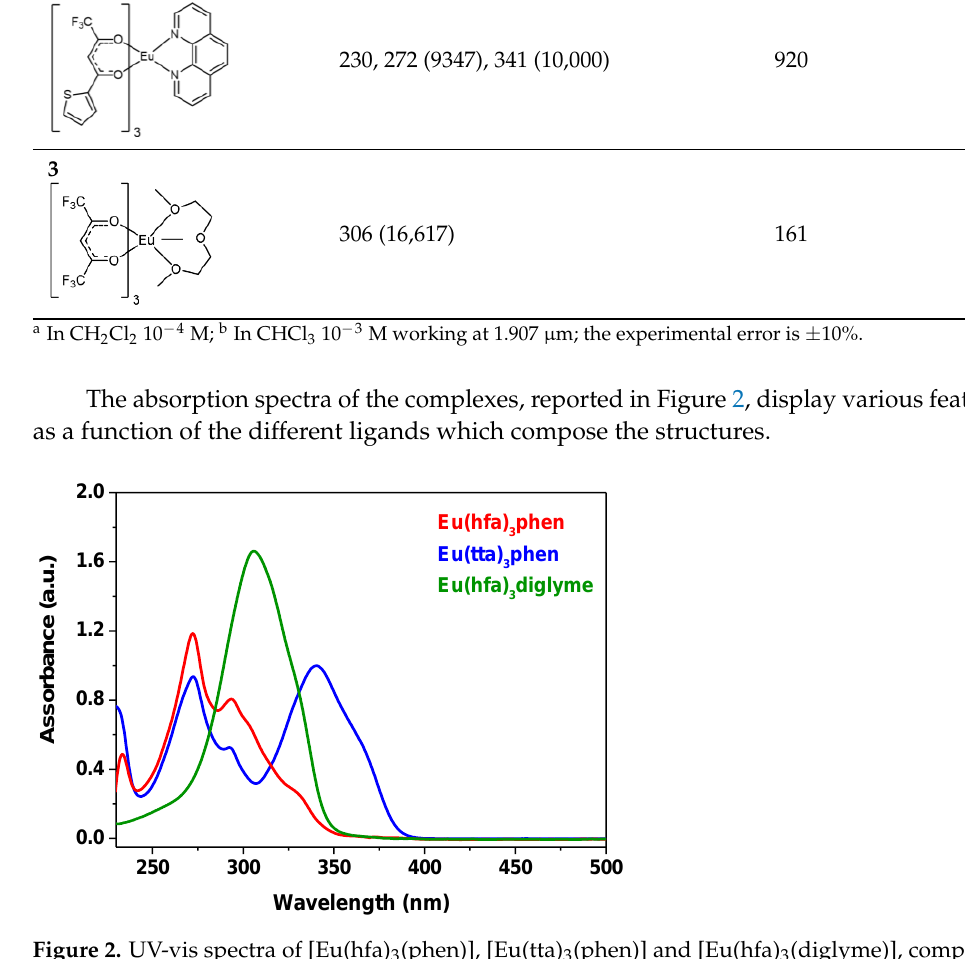
Figure 2. UV-vis spectra of [Eu(hfa) 3 (phen)], [Eu(tta) 3 (phen)] and [Eu(hfa) 3 (diglyme)], complexes from 1 × 10 − 4 M solutions in CH 2 Cl 2 .